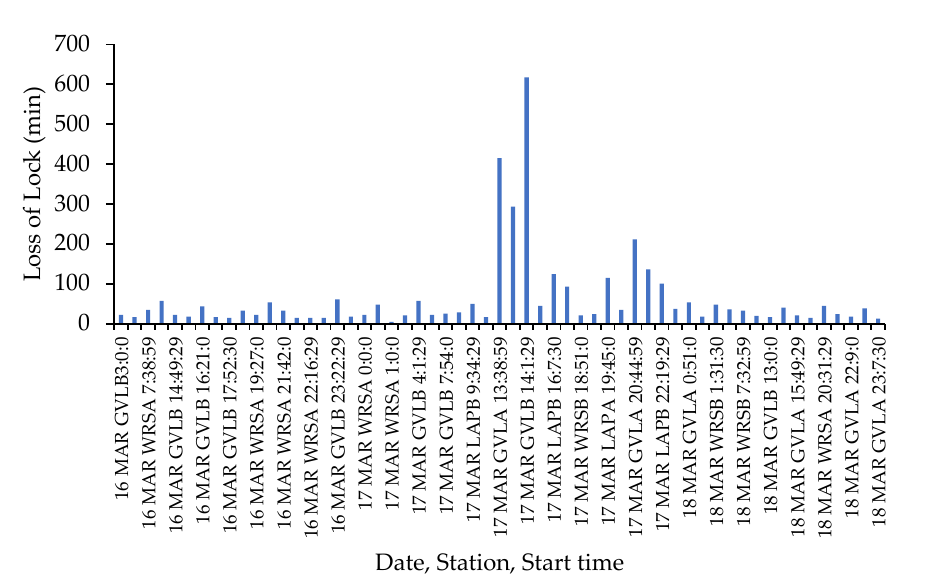
Figure 16. RIMS stations and their respective loss-of-lock start times and durations in minutes. Station GVLA was in a loss of lock for almost 7 h, starting from 13:39:00, LAPA ~5 h, GVLB ~10 h, LAPB ~2 h, and WRSA ~1.5 h from ~16:15:00, GVLA ~3.5 h from 20:45, LAPA ~2 h from 20:45, and LAPB ~2 h from 22:19:30. This means that during the St. Patrick’s